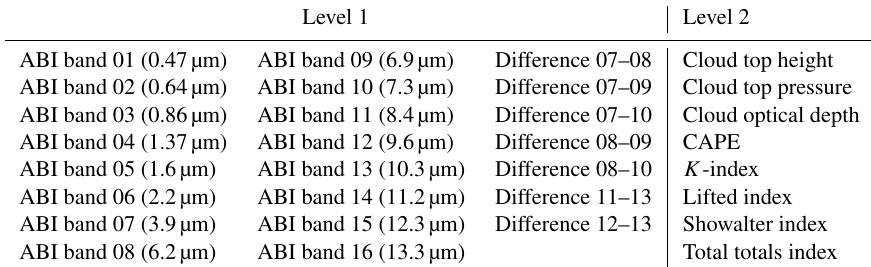
Table B3. Variables from the GOES-16 ABI instrument adopted in this study.